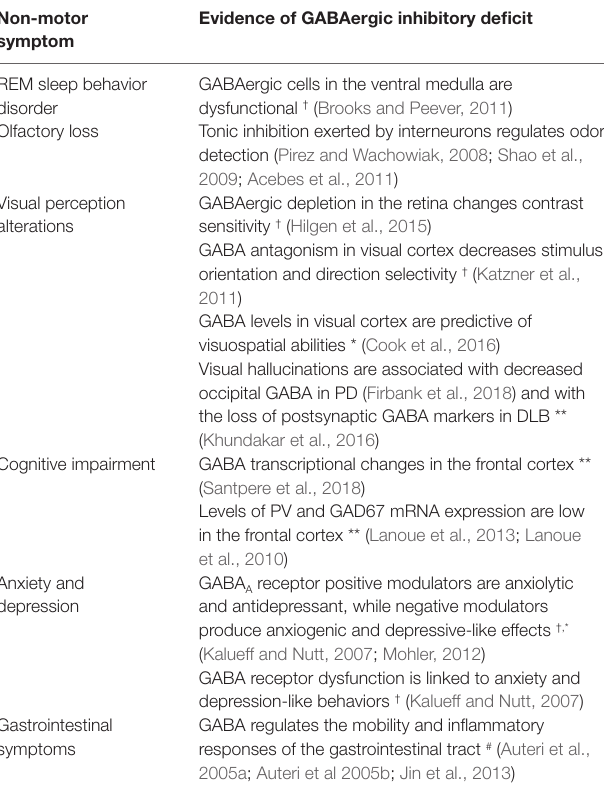
TABLE 1 | Evidence of the involvement of GABAergic neurotransmission in early non-motor symptoms of Parkinson’s